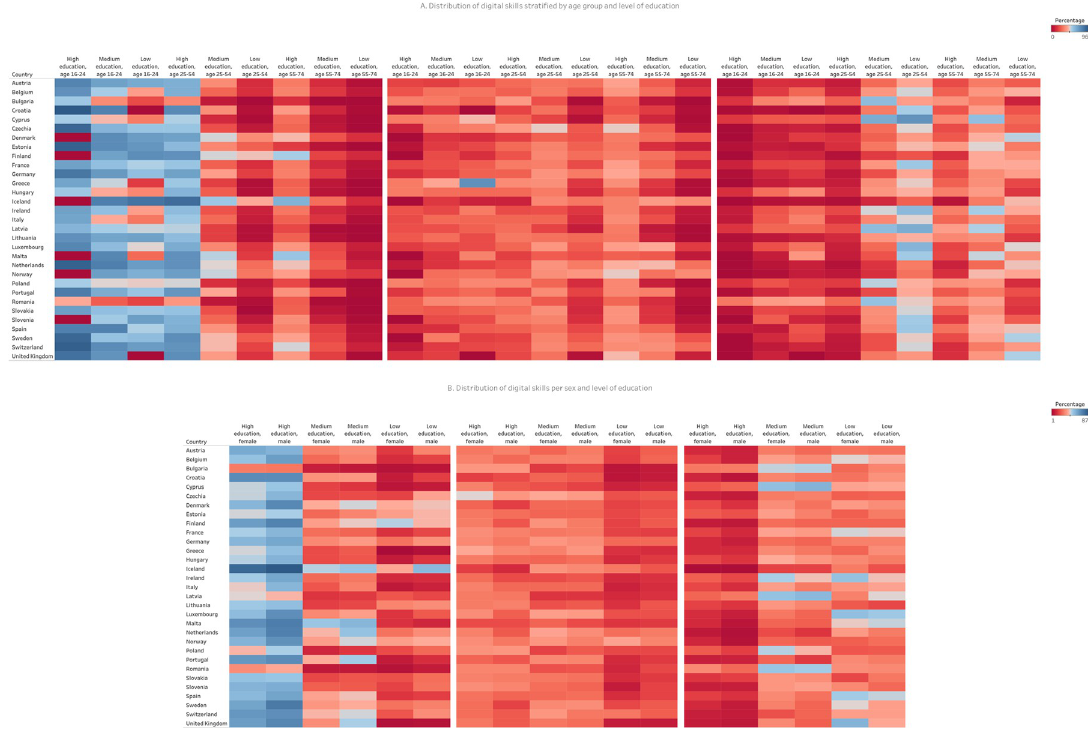
Fig 5. Heat map of digital skills with levels of education sub-stratified by age (Fig 5A) and sex (Fig 5B). The left plot indicates above basic digital skills, the middle plot basic digital skills, and the right plot low digital skills.